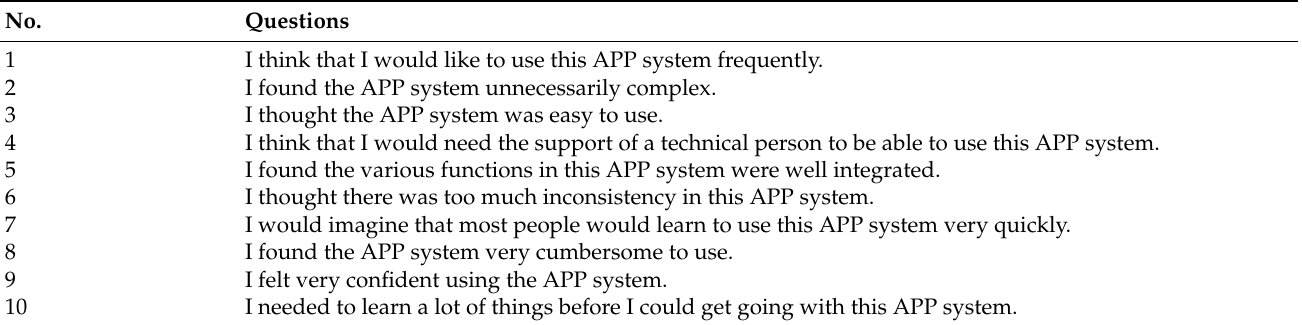
Table 2. The Likert scale items of system usability scale (SUS) questionnaire.